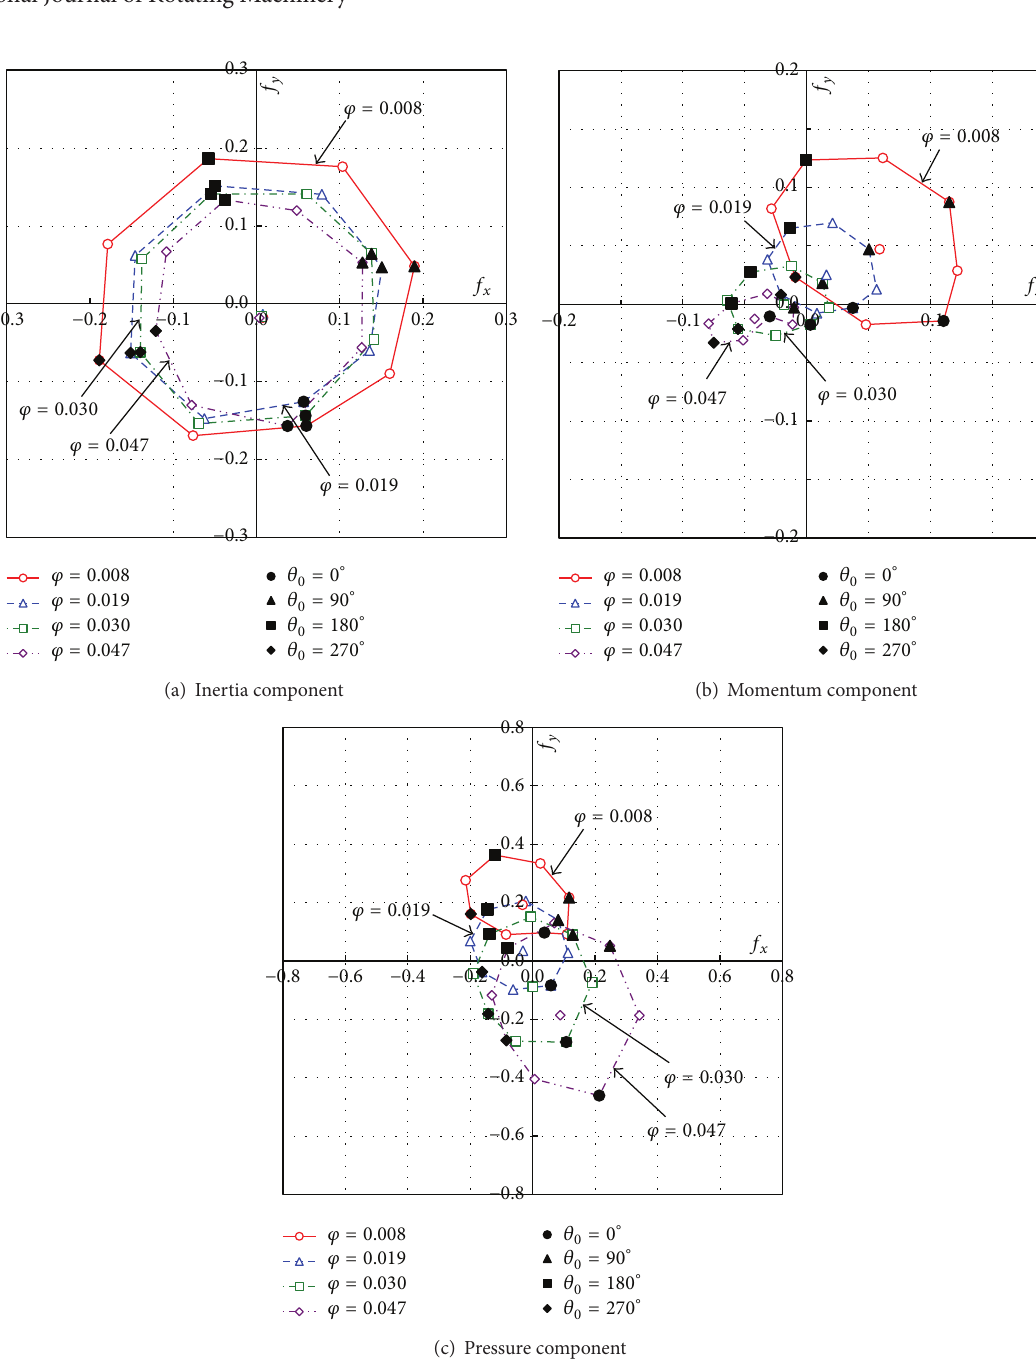
Figure 10: Lissajous figures of each component of radial thrust coefficient ( 𝛽 𝑏2 = 8